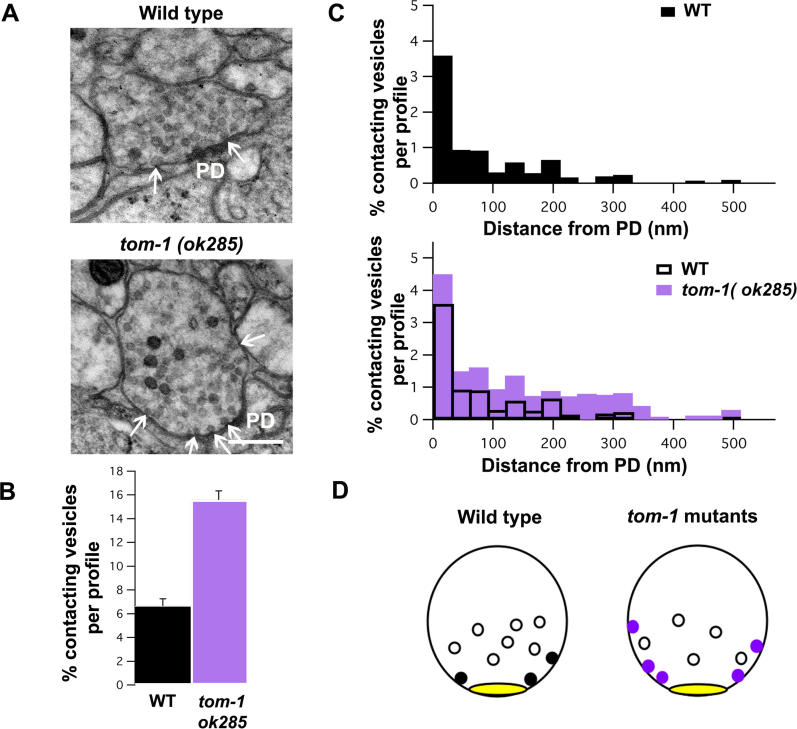
tom-1(ok285) Mutants Accumulate Vesicles That Are Contacting the Plasma Membrane(A) Examples of synaptic profiles from WT and
tom-1(ok285) neuromuscular synapse prepared by high-pressure freeze and freeze substitution. The presynaptic density is labeled PD, and the plasma membrane-contacting vesicles are indicated with arrows. Scale bar, 100 nm.
(B) Vesicles contacting the plasma membrane as a ratio of total vesicles per synaptic profile are increased in
tom-1(ok285) mutant animals.
(C) The distribution of plasma membrane-contacting vesicles relative to the presynaptic density, expressed in 30-nm bins as a ratio of total vesicles per profile for WT and
tom-1(ok285).
(D) Schematic representation of data in (C) depicting the distribution of vesicles contacting plasma membrane (black circles for WT, purple circles for
tom-1 mutants) relative to the presynaptic density. Data expressed as mean ± SEM.